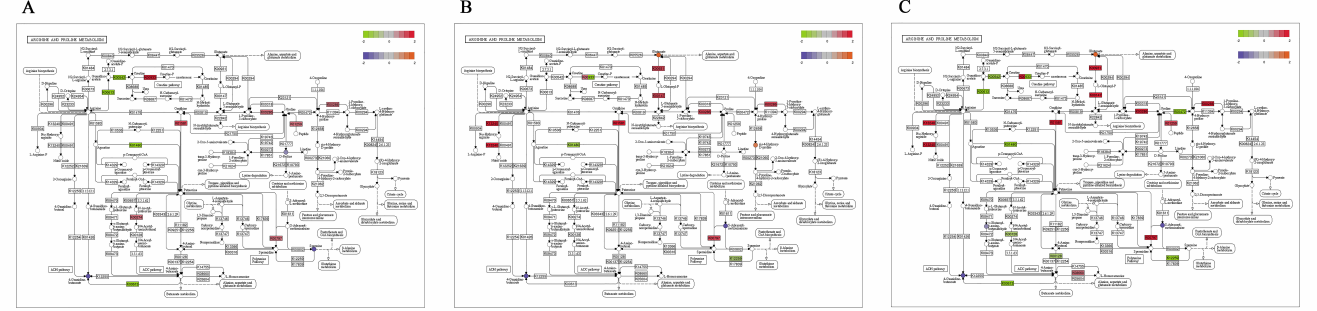
Figure 10. The pathway of Arginine and proline metabolism. ( A ) E15_BM vs. E21_BM; ( B ) E21_BM vs. E27_BM; ( C ) E15_BM vs.